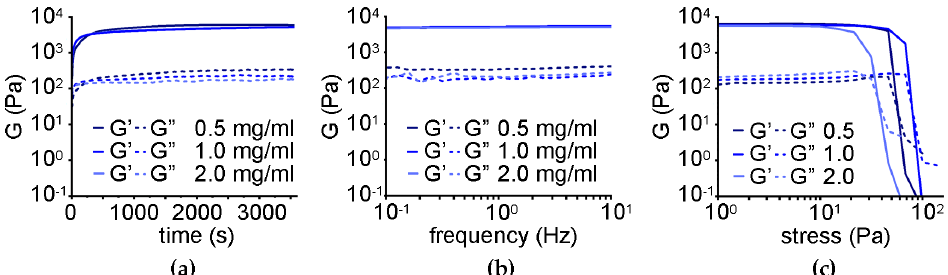
Figure 7. Oscillatory rheology of the nanocomposite supramolecular hydrogels obtained through the non ‐ covalent approach. ( a ) Time sweeps. ( b ) Frequency sweeps. ( c ) Stress sweeps. non-covalent approach. ( a ) Time sweeps. ( b ) Frequency sweeps. ( c ) Stress